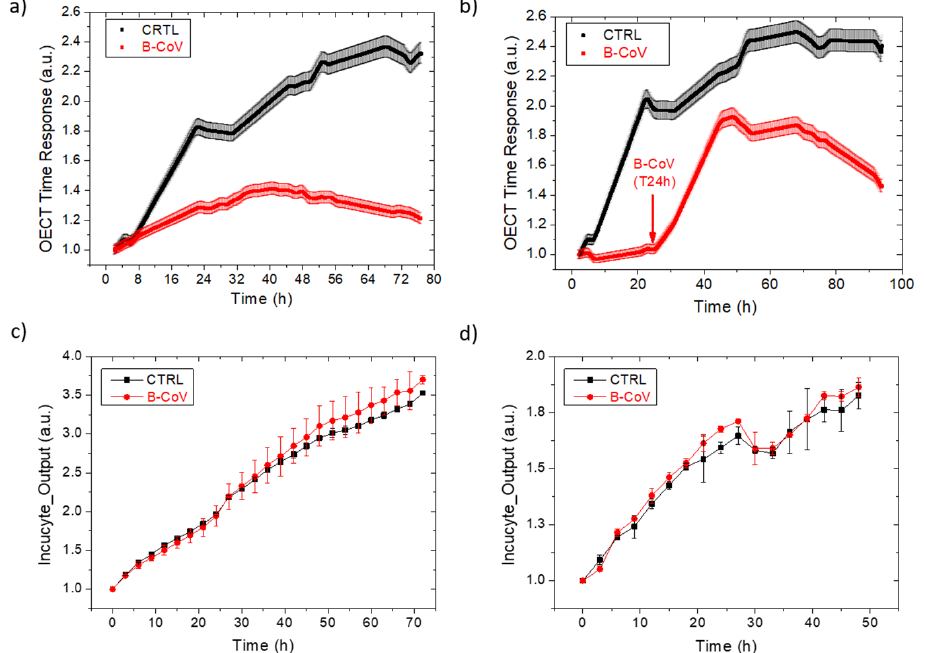
Figure 2. The OECT real-time monitoring of HRT-18 cell growth infected with B-CoV in suspension ( a ) and adhesion ( b ) for 48 h. Each OECT time response point is the average of five consecutive measurements, having the standard deviation reported as the curve shadow. The normalized Incucyte ® data of HRT-18 cell growth, infected with B-CoV in suspension ( c ) and adhesion (( d ), the data were taken and normalized after viral incubation). The experiments were stopped 72 h post virus infection, except for the Incucyte screening in adhesion, which was stopped after 48 h since a clear cytopathic effect had already been monitored by the OECTs.